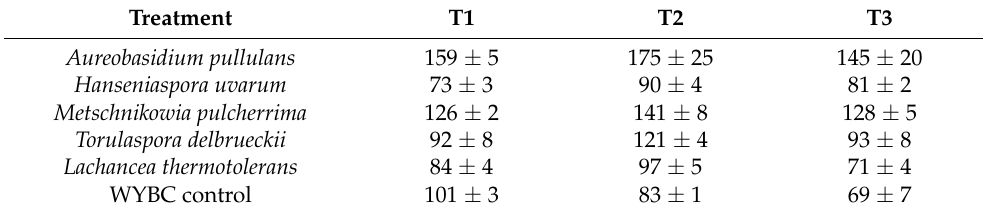
Table 2. Sugar concentration (g/L) at each time point (3 days after S. cerevisiae inoculation). All data points correspond to the mean of three replicates ±